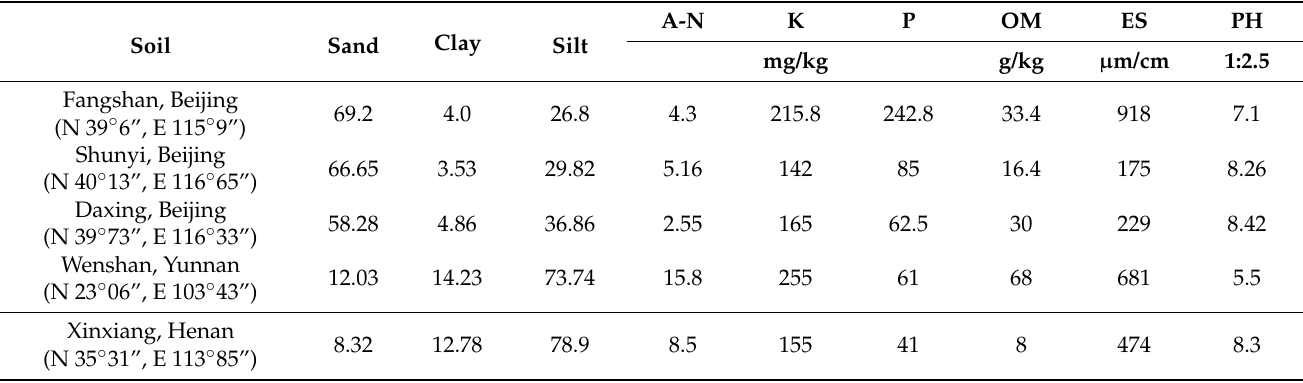
Table 2. Physical and chemical properties of